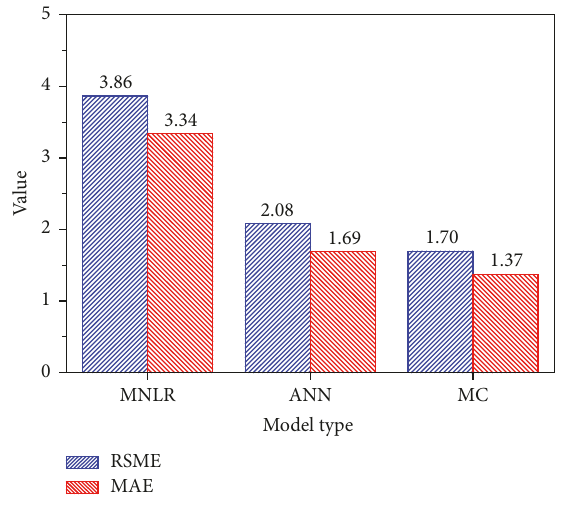
Figure 3: Quantitative comparison of different